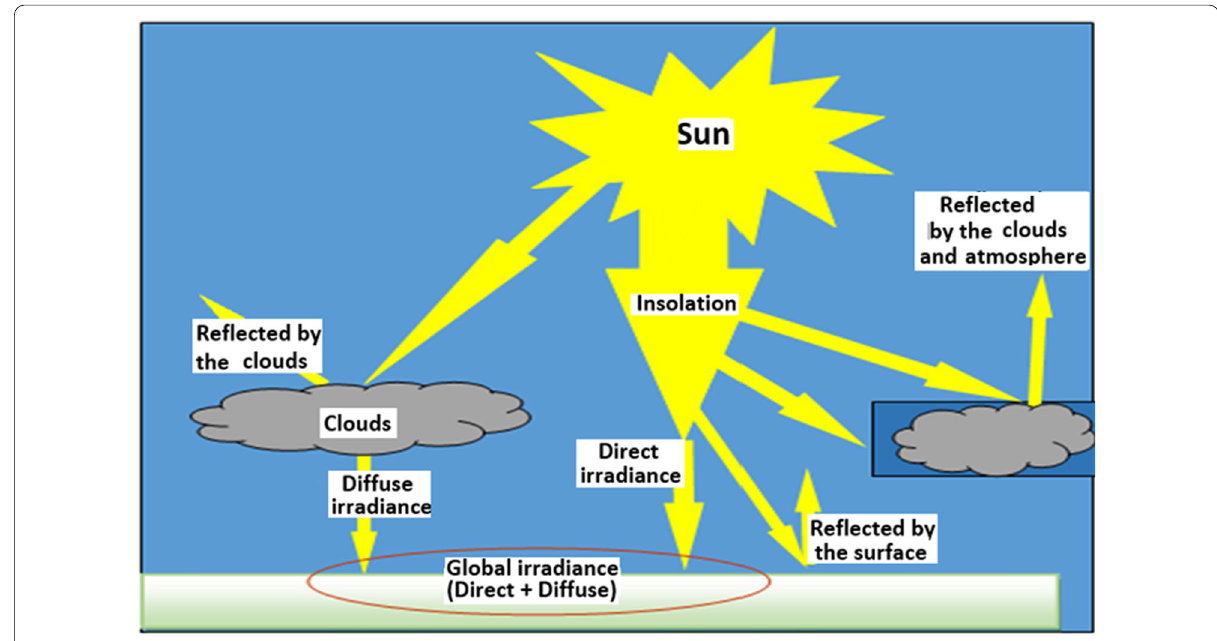
Fig. 3 Components of total/global radiation (direct, diffused, and reflected